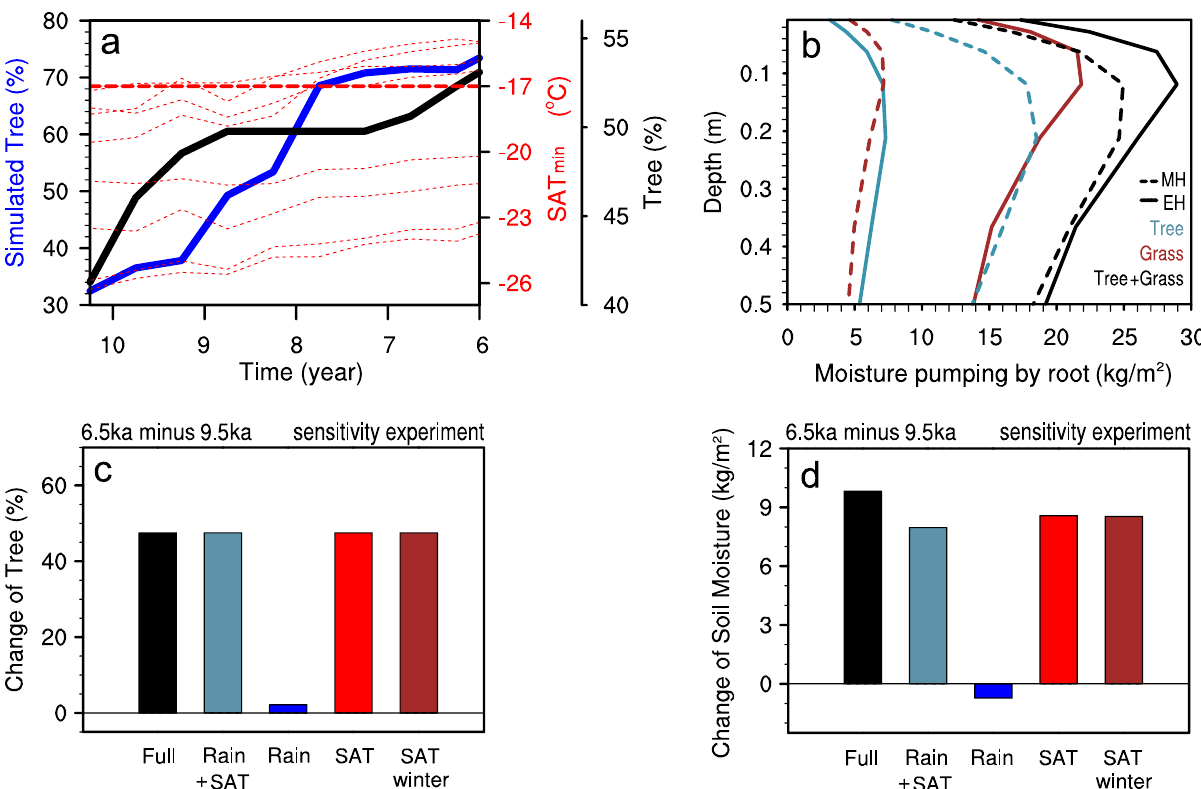
Fig. 4 Change of tree percentage and moisture pumping over Northern China (NC) from the early Holocene (EH) to mid-Holocene (MH). a Evolutions of tree percentage in proxy records 14 (black) and TraCE21 simulation (blue) over the period of EH to MH. Coldest temperature in the winter season (SAT min ) in each grid box within the NC region is also shown as thin red dashed lines, with the temperature threshold ( − 17 °C) for broadleaf trees and grass in the model as the thick red-dash line. b Vertical pro fi les of the moisture pumping by root for trees (cadetblue), grasses (brown), and the sum (black) in EH (9.5 ka, solid) and MH (6.5 ka, dash). Changes of c tree percentage and d soil moisture from EH to MH in an off-line land-vegetation-coupled model that forced by TraCE21 atmospheric variables in different combinations: full forcing (Full, black), rainfall and temperature forcing (Rain + SAT, cadetblue), rainfall only (Rain, blue), temperature only (SAT, red), and winter temperature only (SAT winter,